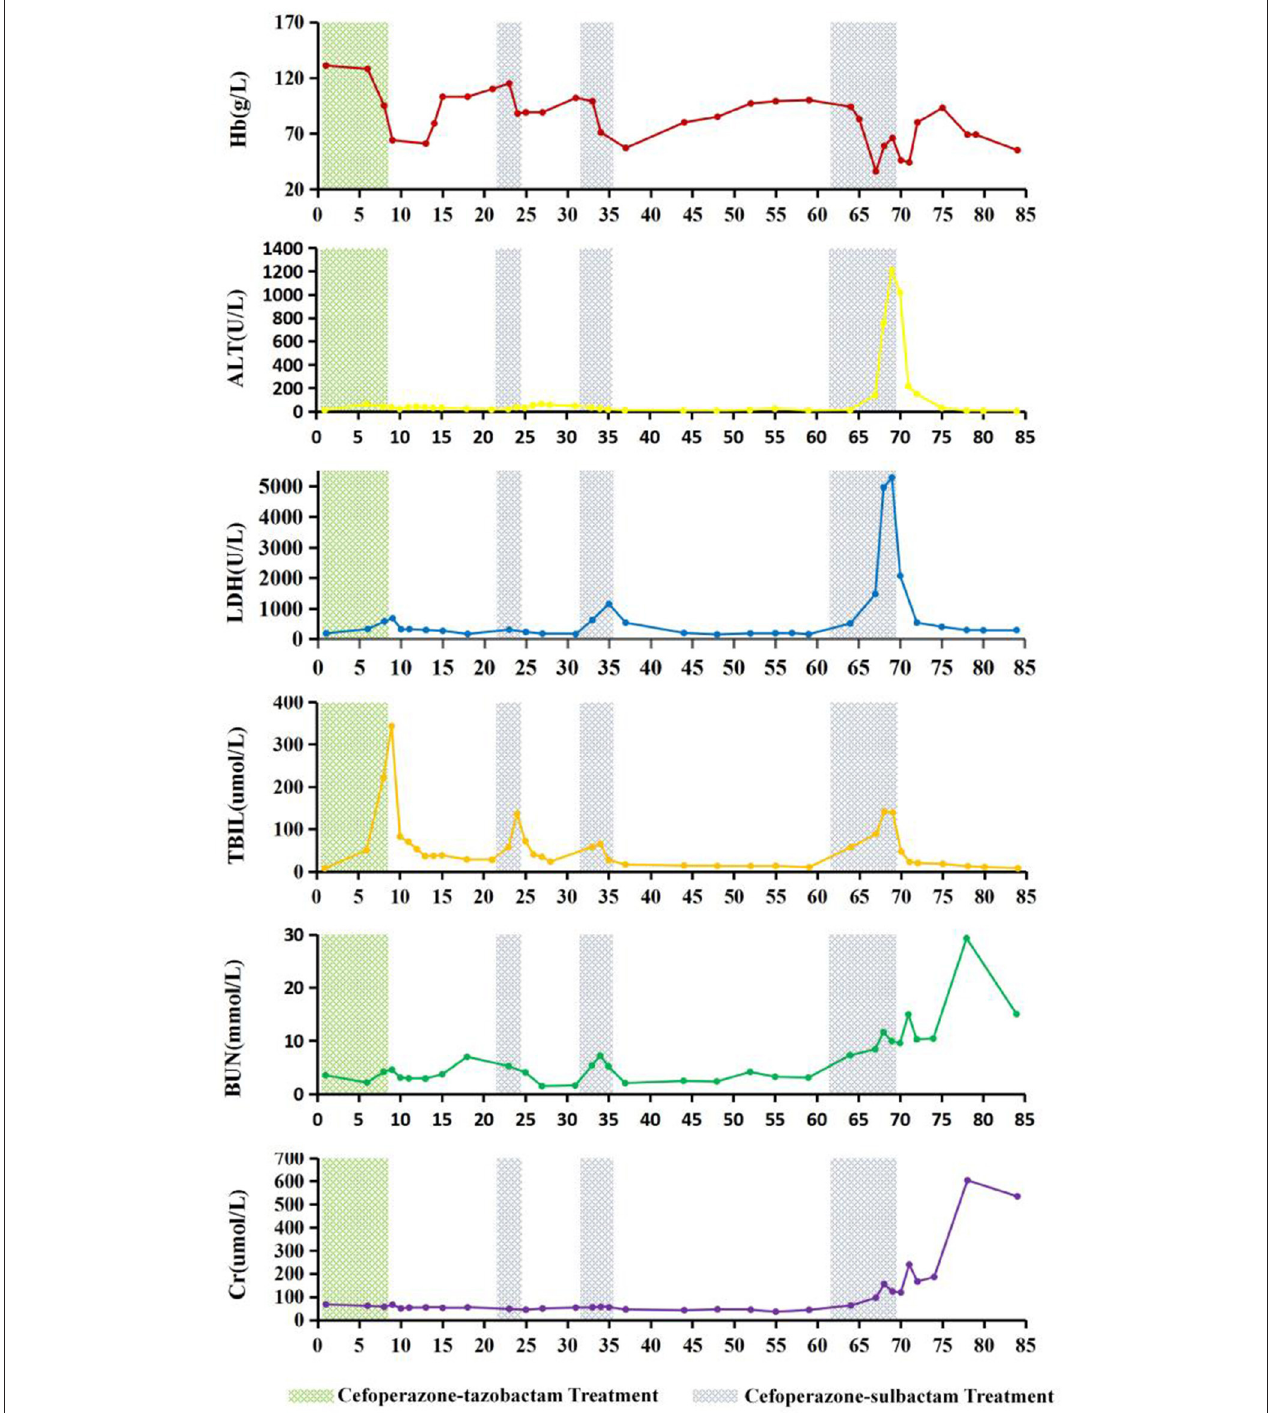
FIGURE 1 | Changes in haemoglobin (Hb), alanine transaminase (ALT), lactate dehydrogenase (LDH), total bilirubin (TBIL), blood urea nitrogen (BUN), and creatinine (Cr) levels during cefoperazone-tazobactam and cefoperazone-sulbactam treatment. On the 9th day of hospitalization, therapeutic plasma exchange (TPE) with 2,100mL of frozen plasma and bilirubin adsorption treatment were performed. On days 13 and 14, leukocyte-reduced red blood cells (LRBCs) prepared from 1,200mL of whole blood were infused. On day 24, TPE with 2,000mL of frozen plasma and bilirubin adsorption treatment were performed. On day 67